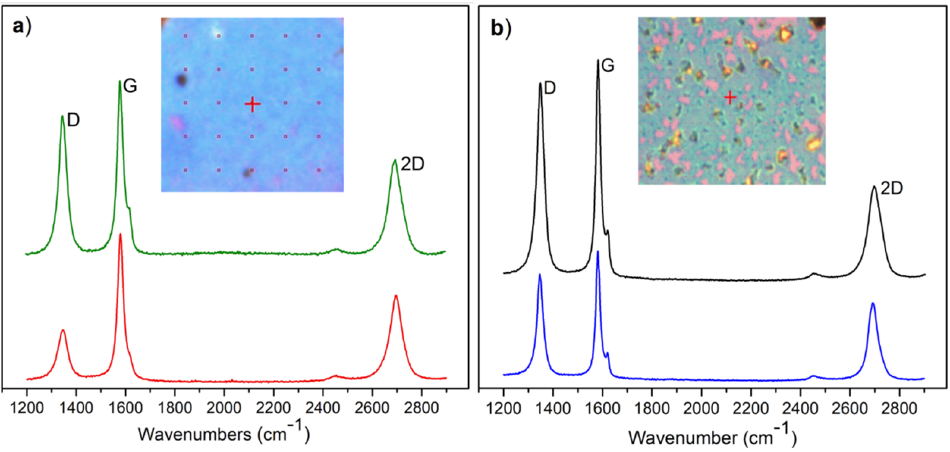
Figure 2. Raman spectra of graphene on SiO 2 /Si substrates and its respective peaks (D, G and 2D): ( a ) Next to the copper-strip areas and ( b ) On top of the copper-strip areas. The average intensity ratio between the D and G peaks (I D/G ) yields an estimate of the graphene grain size [39,40] and the level of the defective crystallites [36,37,41,42]. In our case, these values were between 0.30 ± 0.04 and 0.80 ± 0.03 next to the copper strip. The higher I D/G values, 0.45 ± 0.07 and 0.87 ± 0.03, were found on top of the metal strip. Although, we had a significant observed D peak, the average of the full width at half maximum (FWHM) of the D, G and 2D peaks indicates good quality crystallites [36]. The FWHM of these peaks on top of the copper strip were 35 ± 1 cm − 1 , 25 ± 1 cm − 1 , and 56 ± 3 cm − 1 , respectively and in areas next to the copper strip were: 38 ± 2 cm − 1 , 29 ± 1 cm − 1 and 52 ± 2 cm − 1